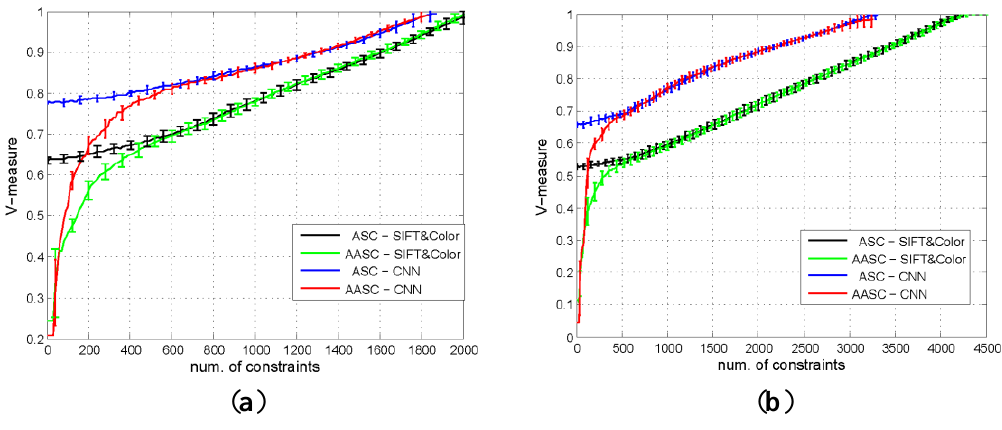
Figure 17. Comparison of performance using different similarity measures. The number of constraints decreases when better features are used: ( a ) WHU-RS and ( b )